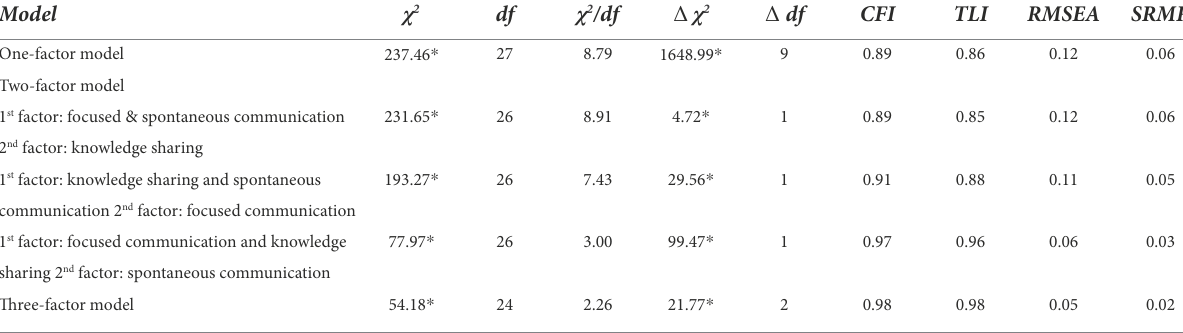
TABLE 3 Study 3: Confirmatory factor analysis on the individual level.